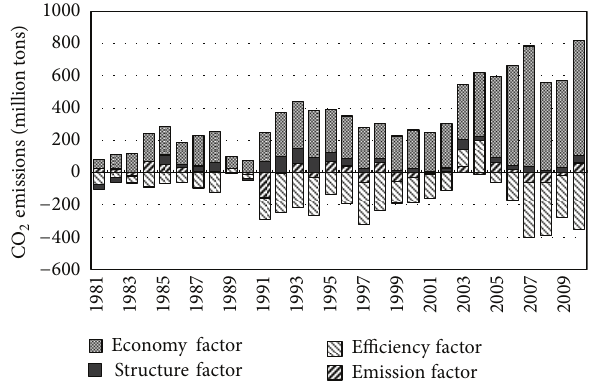
Figure 3: Accumulated CO 2 emissions change of industrial sector (1981–2010).